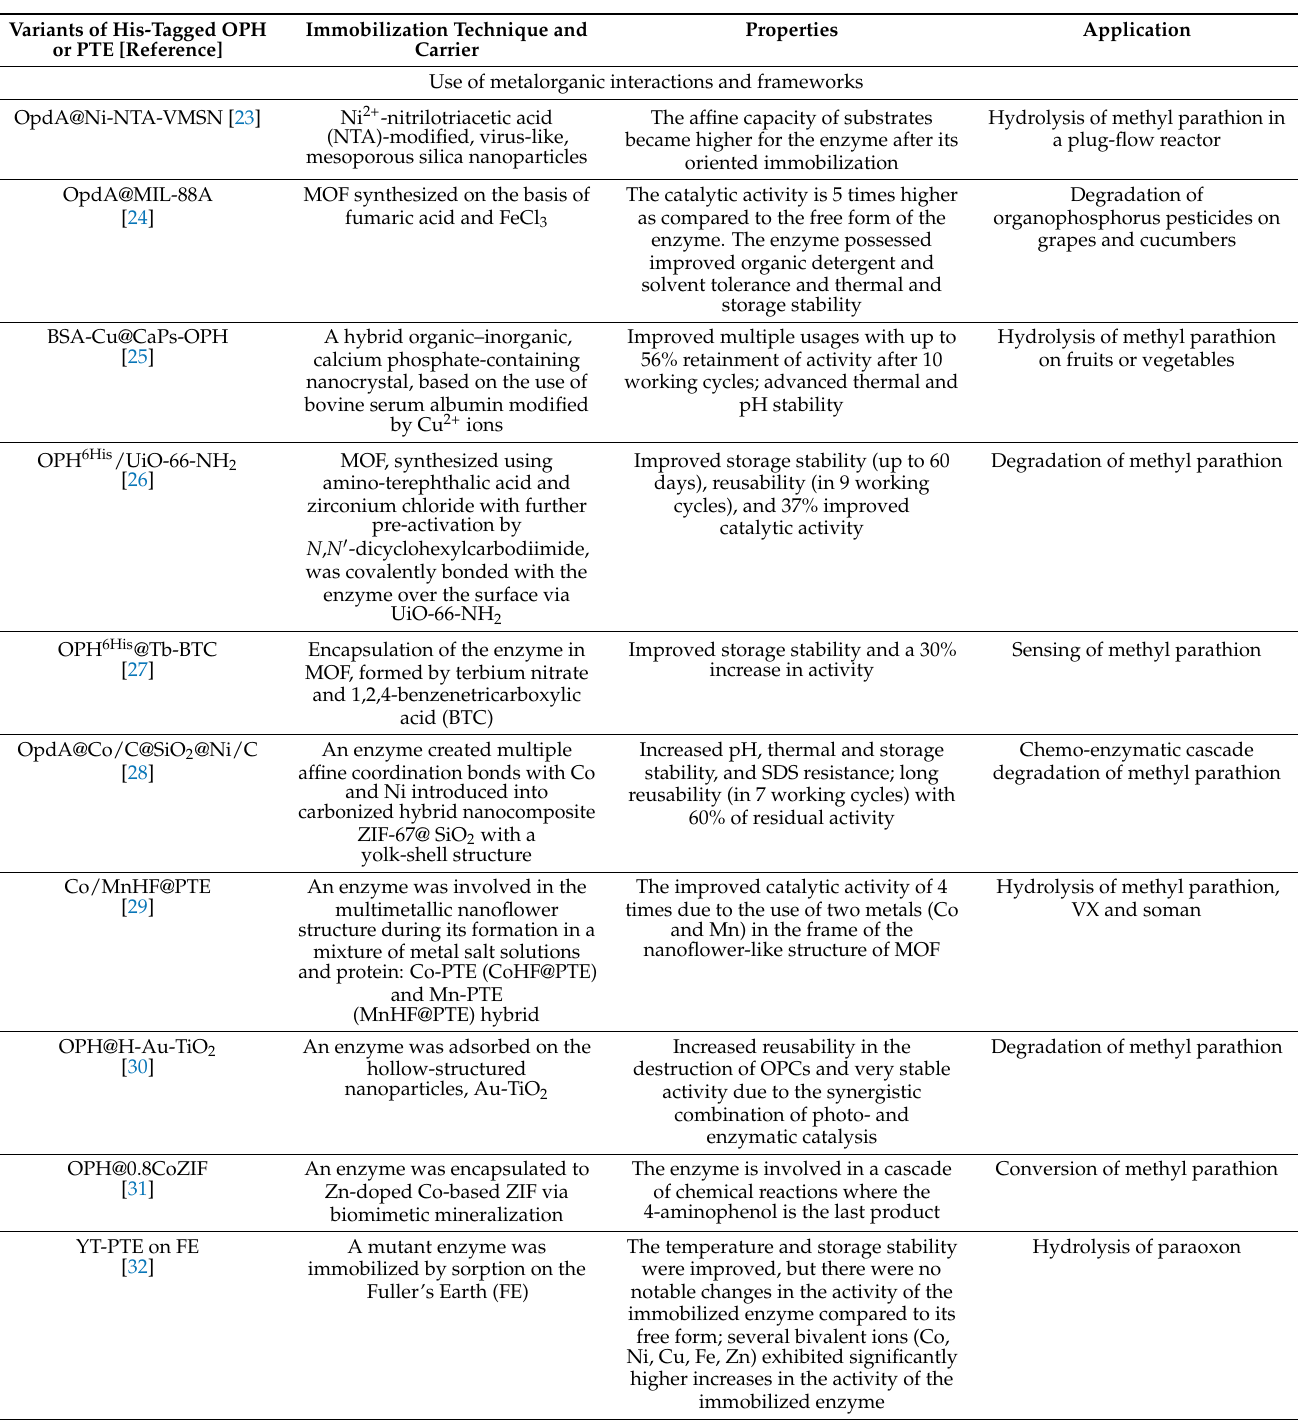
Table 1. Samples of immobilized and stabilized forms of His 6 -OPH for reactions with OPCs. Variants of His-Tagged OPH or PTE